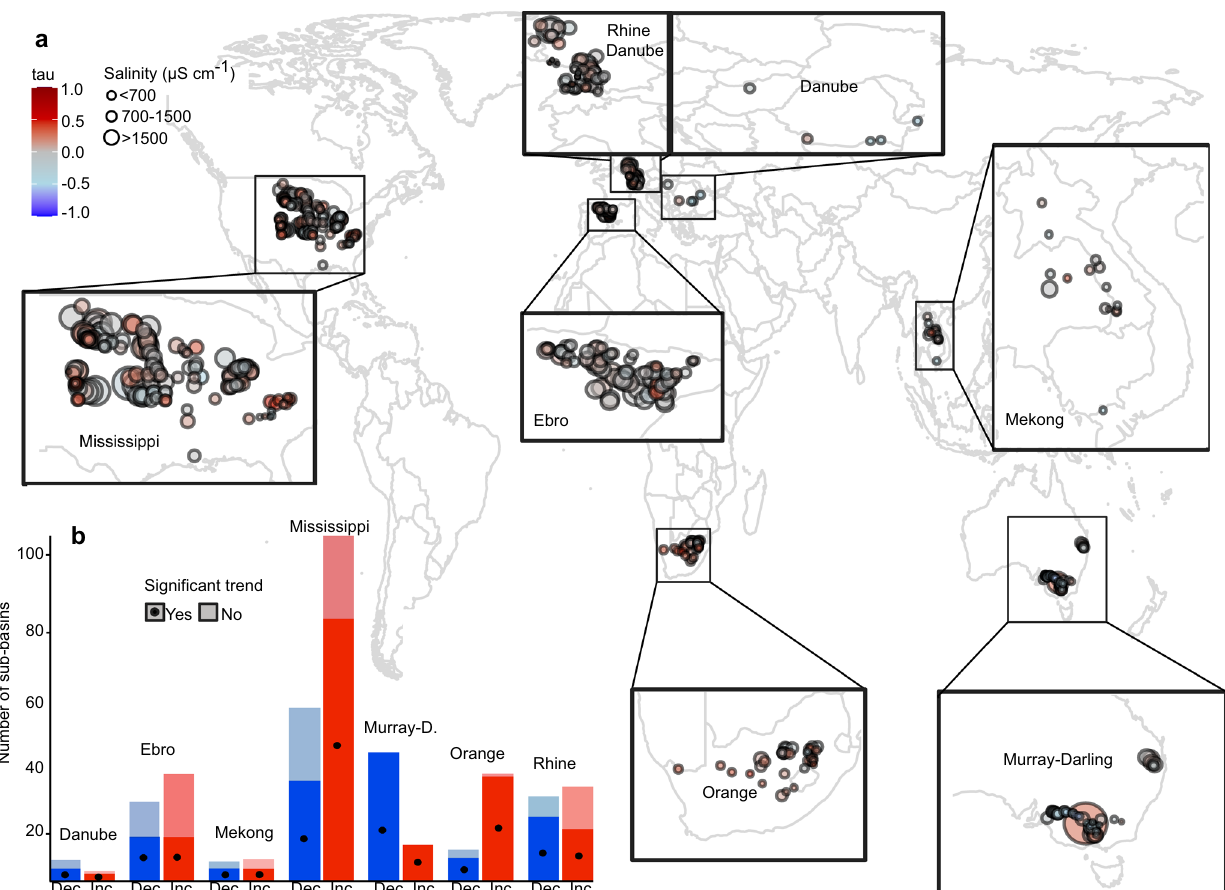
Fig. 5 Salinity levels and trends across and within the seven regional river basins. Panel a shows an overview of long-term salinity levels (size of circle) and Mann-Kendall trend test results (colour of circle) for each sub-basin monitoring location over the study period (1980 – 2010). Salinity trends are expressed in tau-values, ranging from − 1 to 1, where negative values (in blue) indicate decreasing salinity trends and positive values (in red) indicate increasing salinity trends. The stacked bar-plot in panel b , shows the distribution of the number of sub-basins with increasing (red) vs. decreasing (blue) salinity trends within each regional river basin and whether the trend is statistically signi fi cant (darker colour with dot) or not (lighter colour), estimated at the 95% con fi dence level ( p value <